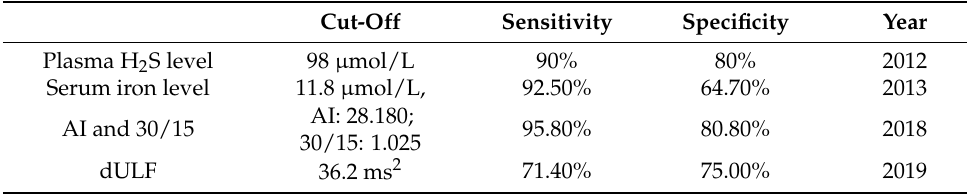
Table 1. Clinical indicators used to differentiate POTS from VVS.